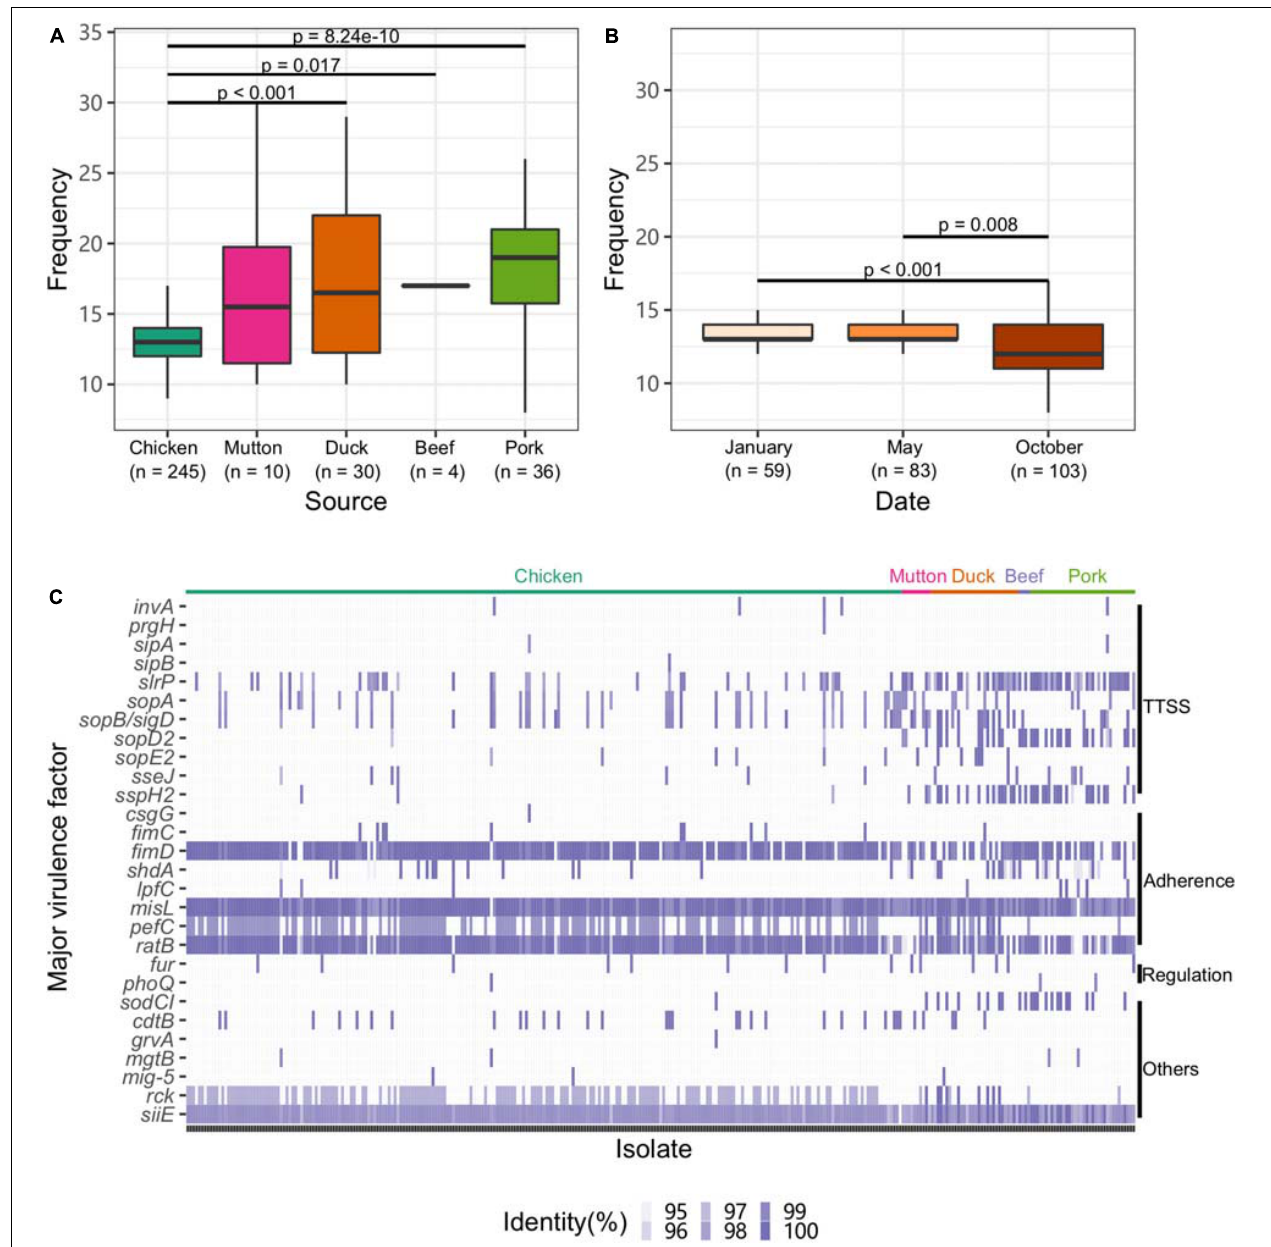
FIGURE 4 | Profile of VFs in the Salmonella genome. (A) Numbers of VFs in the genomes of Salmonella isolates from different retail meats. (B) Numbers of VFs in the genomes of Salmonella isolates from different sampling time points. (C) Major VF profile in the Salmonella genome. TTSS, Type III secretion system.